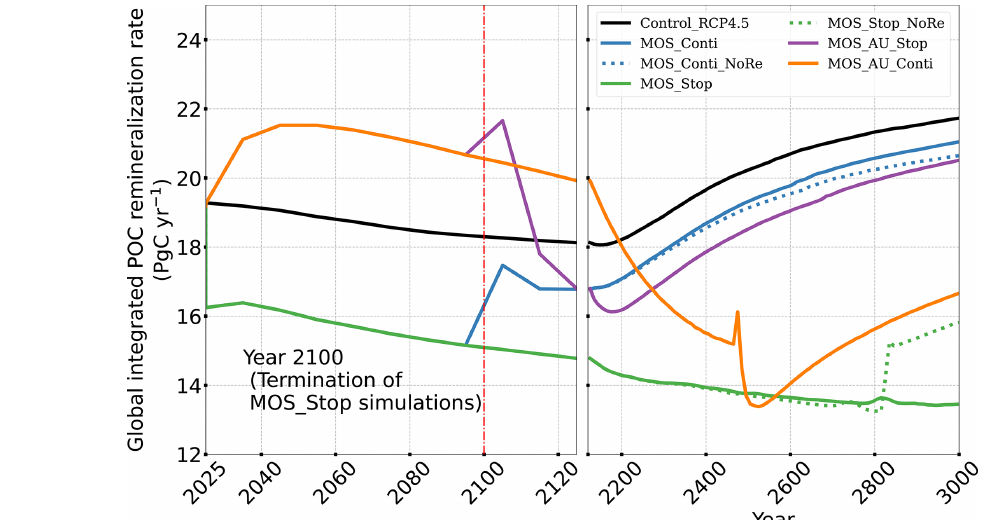
Figure B7. Plot of upper-ocean 0–2000m averaged detritus remineralization rate.